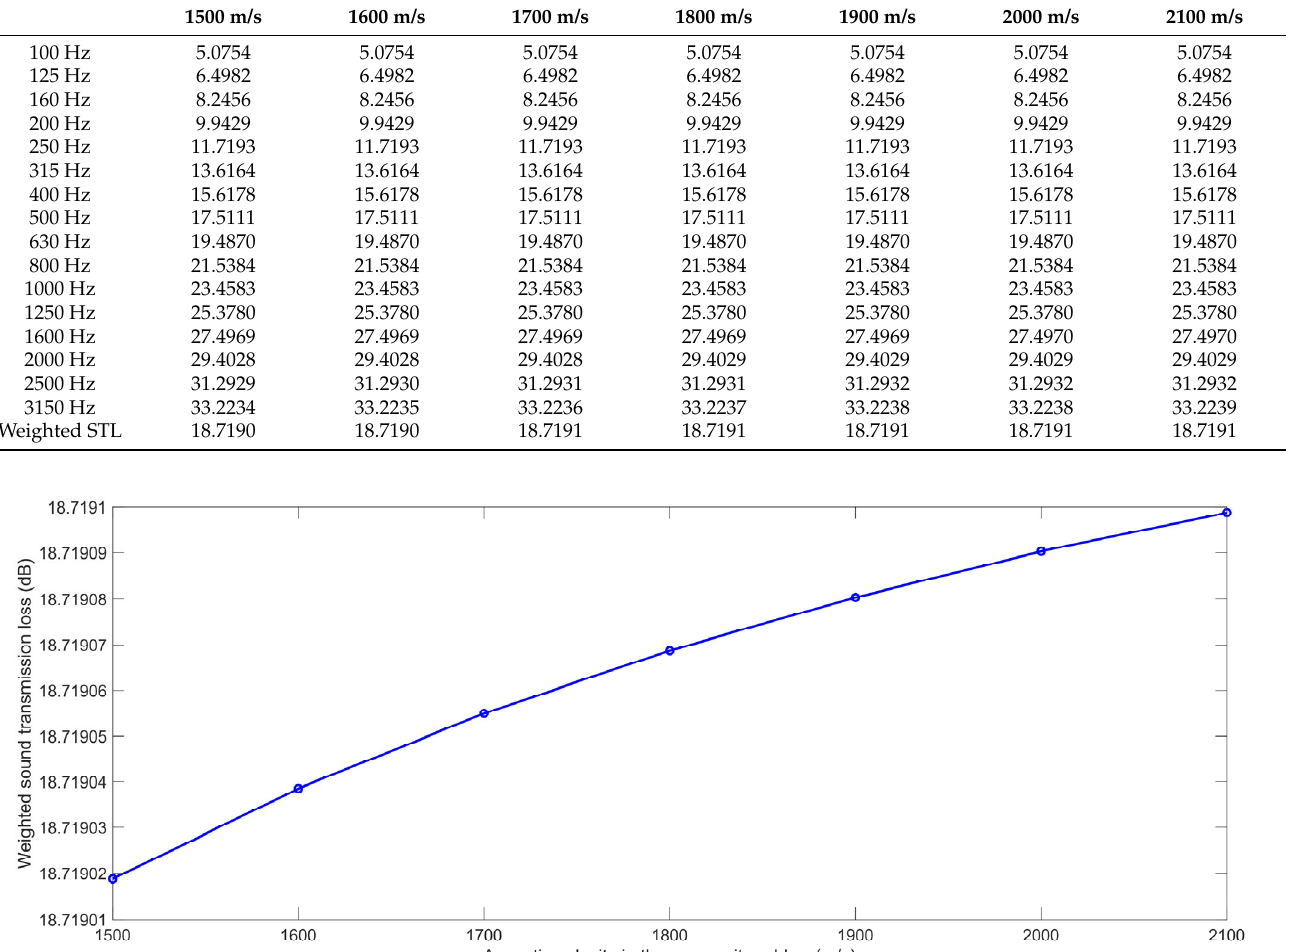
Table 9. The summarized STL data with the various acoustic velocity in the composite rubber.